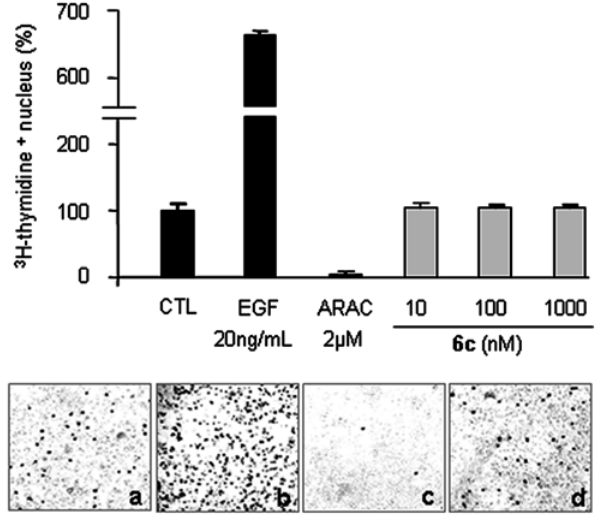
Figure 5. Compound 6c-induced neurotrophic effect is inde- pendent of glial proliferation. Proliferation in mesencephalic cultures was not affected by compound 6c treatment (d) compared to non-treated cultures (CTL) (a). EGF at 20 ng/mL (b) and arabinoside-C (ARA-C) at 2 m M (c), respectively, were used as controls for activation or inhibition of cell proliferation. [ 3 H]-thymidine was added to the cultures for 18 h from DIV7 to DIV8. Proliferation was assessed by counting [ 3 H]- thymidine + nuclei appearing from autoradiographic emulsion. Images were acquired with a phase-contrast microscope coupled to a digital camera. Values are normalized to the non-treated cultures (CTL) and represent the average of three assays performed in triplicate and expressed as mean 6